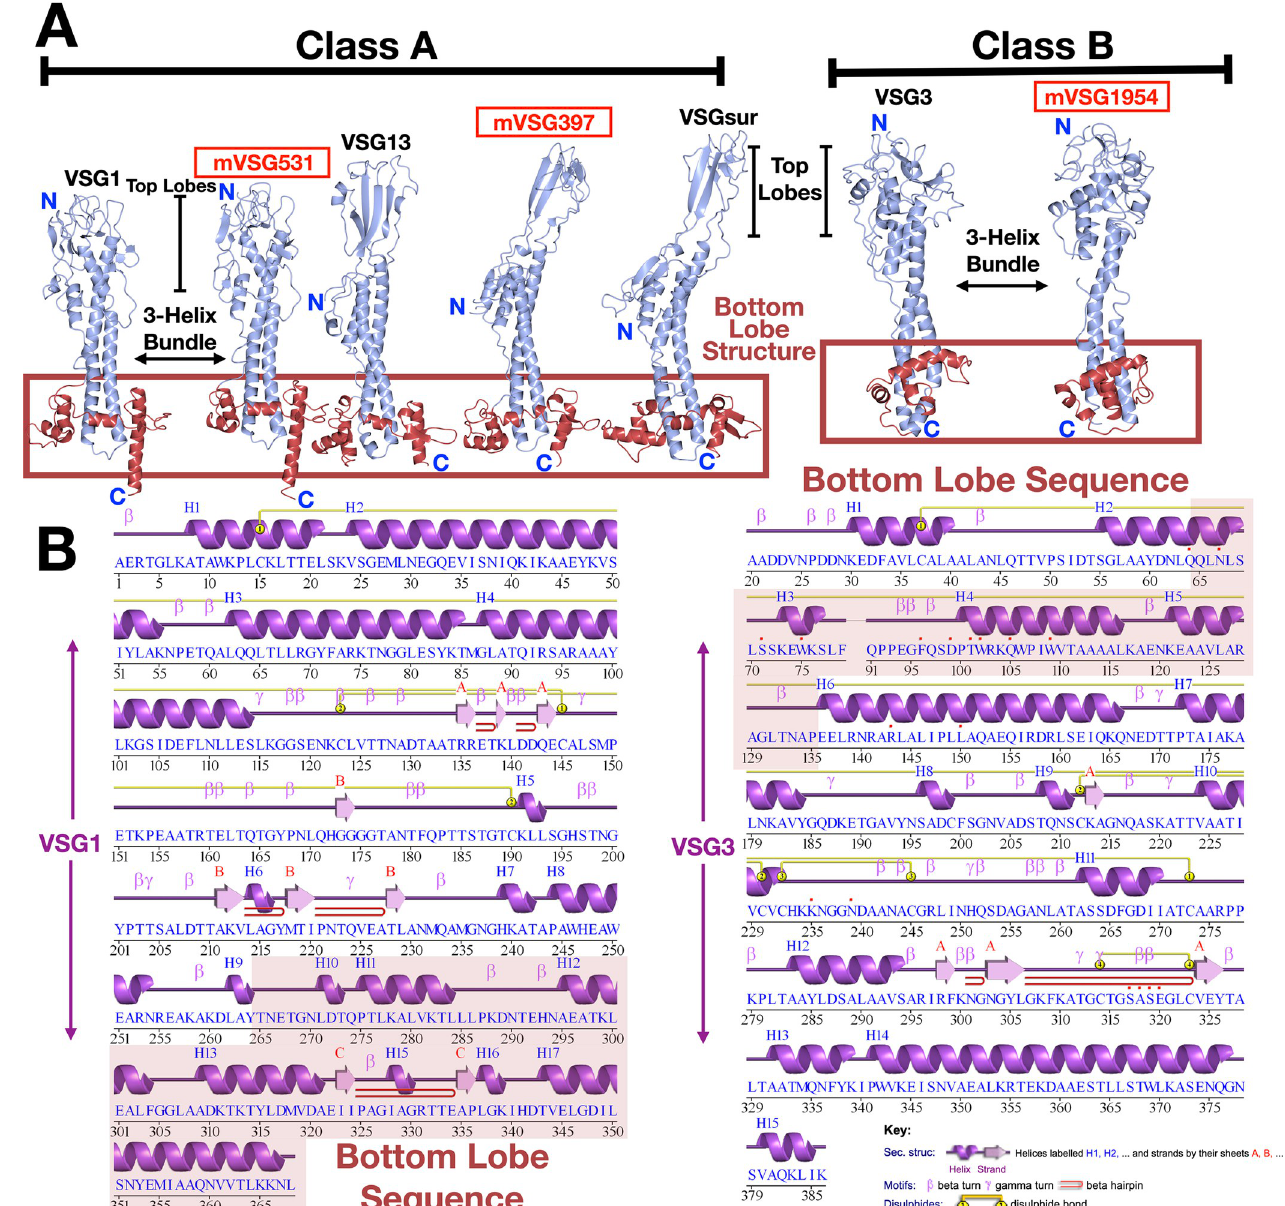
Fig 1. Structural classification of VSG proteins. (A) Two broad superfamily classes of VSGs identified through sequence analysis and defined by structural topology are shown here with representative structures. VSG monomers are shown as ribbon diagrams colored in light blue. Structures reported in this manuscript are denoted in red. The lower, bottom lobe subdomains of the VSGs are outlined with a red box. Structures were drawn with CCP4 mg [57]. (B) Sequence and structurally-determined secondary structure of two representative VSGs from Class A (VSG1) and Class B (VSG2). The sequence region that forms the bottom lobe is indicated by red highlighting. Secondary structure was illustrated with PDBSUM [58]. of the top lobe. Finally, as with VSGsur, the N-terminus of the protein is not at the uppermost surface, but located below the top-lobe and N-linked glycan, possibly buried significantly when packed on the membrane. Overall, mVSG397 and VSGsur align with a root mean square deviation (RMSD) of 2.33 Å over 334 residues (Fig 2B). Consistent with the functional VSGs possessing antigenic distinctiveness to the immune system, the molecular surface of mVSG397